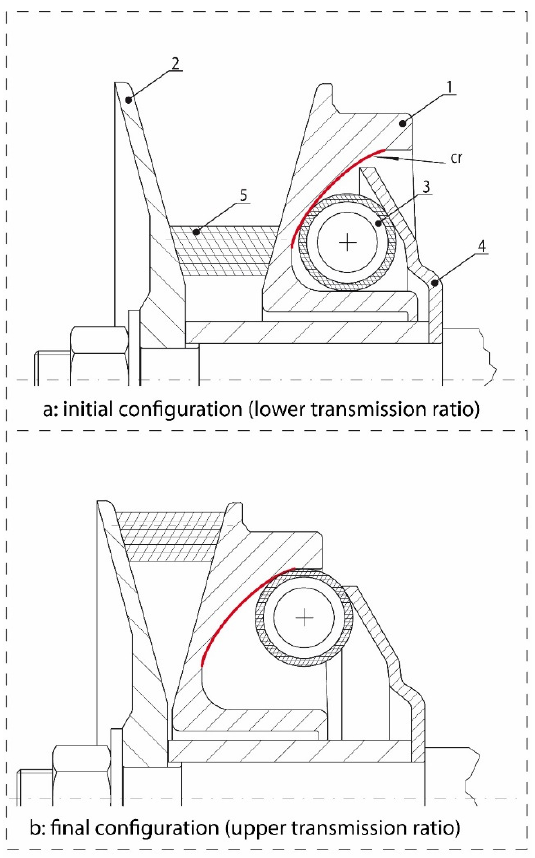
Figure 3. Front assembly initial/starting configuration ( a ) and final configuration ( b ).